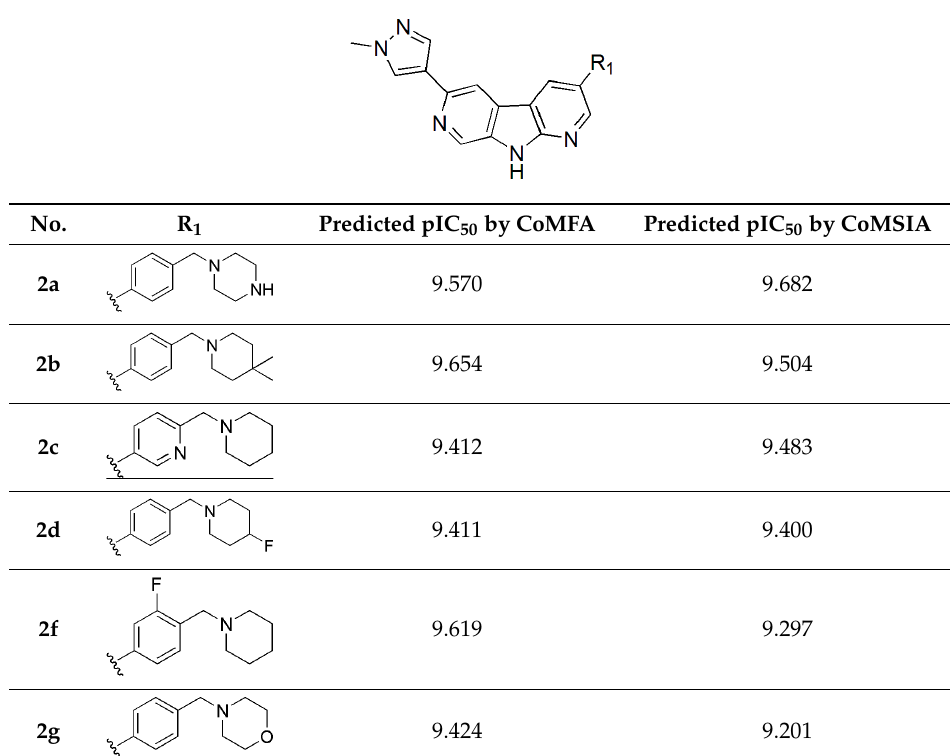
Table 3. Designed molecules and predicted inhibit activities values of Chk 1 through CoMFA and CoMSIA.